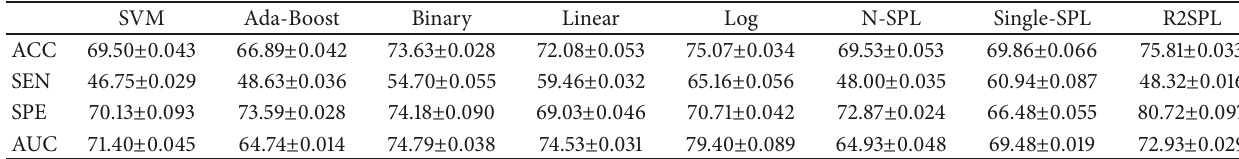
Table 5: Results of seven baselines and our model on the task of SMC versus